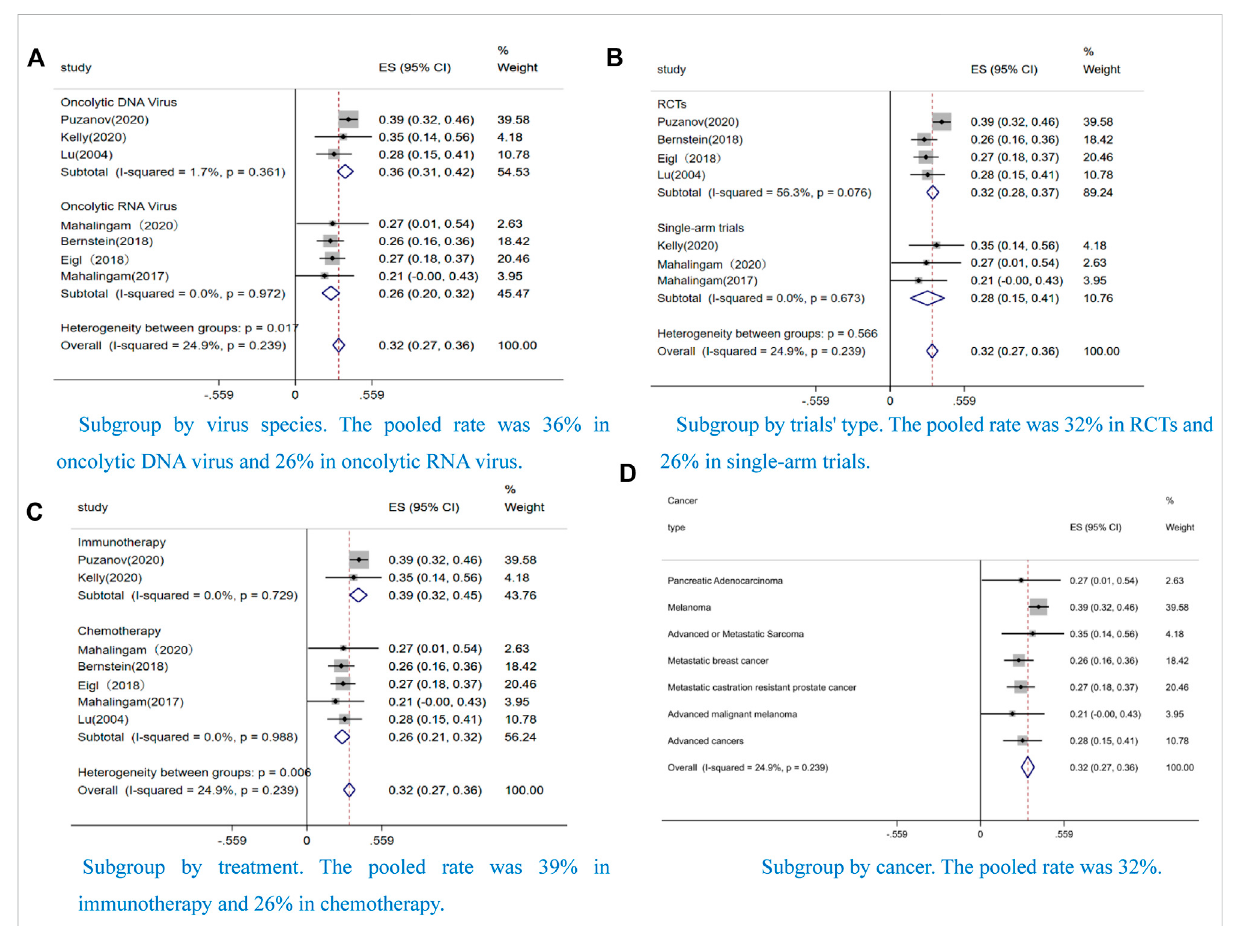
FIGURE 6 Forest plot of the pooled objective response rates (ORRs) in different subgroups, including (A) Subgroup by virus species (B) Subgroup by trials ’ type (C) Subgroup by treatment (D) Subgroup by cancer.